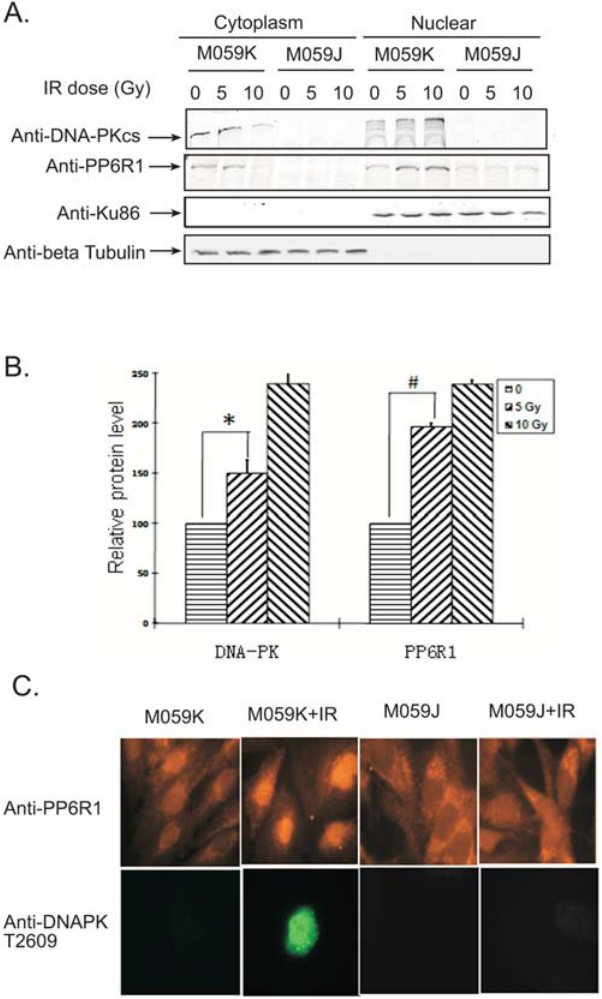
Figure 2. IR-induced nuclear localization of PP6R1 is DNA-PK dependent. A. M059K and M059J cells were left untreated or irradiated with 5 or 10 Gy. One hour after irradiation, cells were lysed and fractionated into cytoplasmic and nuclear fractions. The protein levels of DNA-PKcs and PP6R1 in these fractions were subjected to immunoblot analysis. b -Tubulin and Ku86 are markers for cytoplasmic and nuclear fractions, respectively. B. Immunoblots of the nuclear fractions were quantified by densitometry. The standard error bars represent means of three independent experiments ( 6 SD). The statistical significance of the differences between the amount of DNA- PKcs or PP6R1 in the nuclear fraction from irradiated cells, compared with the nuclear fraction of non-irradiated control cells, was (***, p , 0.001) by Student T test. C. M059K and M059J cells grown on chamber slides were irradiated with 5 Gy, or sham-irradiated. One hour post-irradiation, cells were fixed and immunostained with PP6R1 and DNA-PKcs antibodies. Upper row: orange PP6R1 staining, lower row: green phosphorylated DNA-PKcs Thr2609 stain.